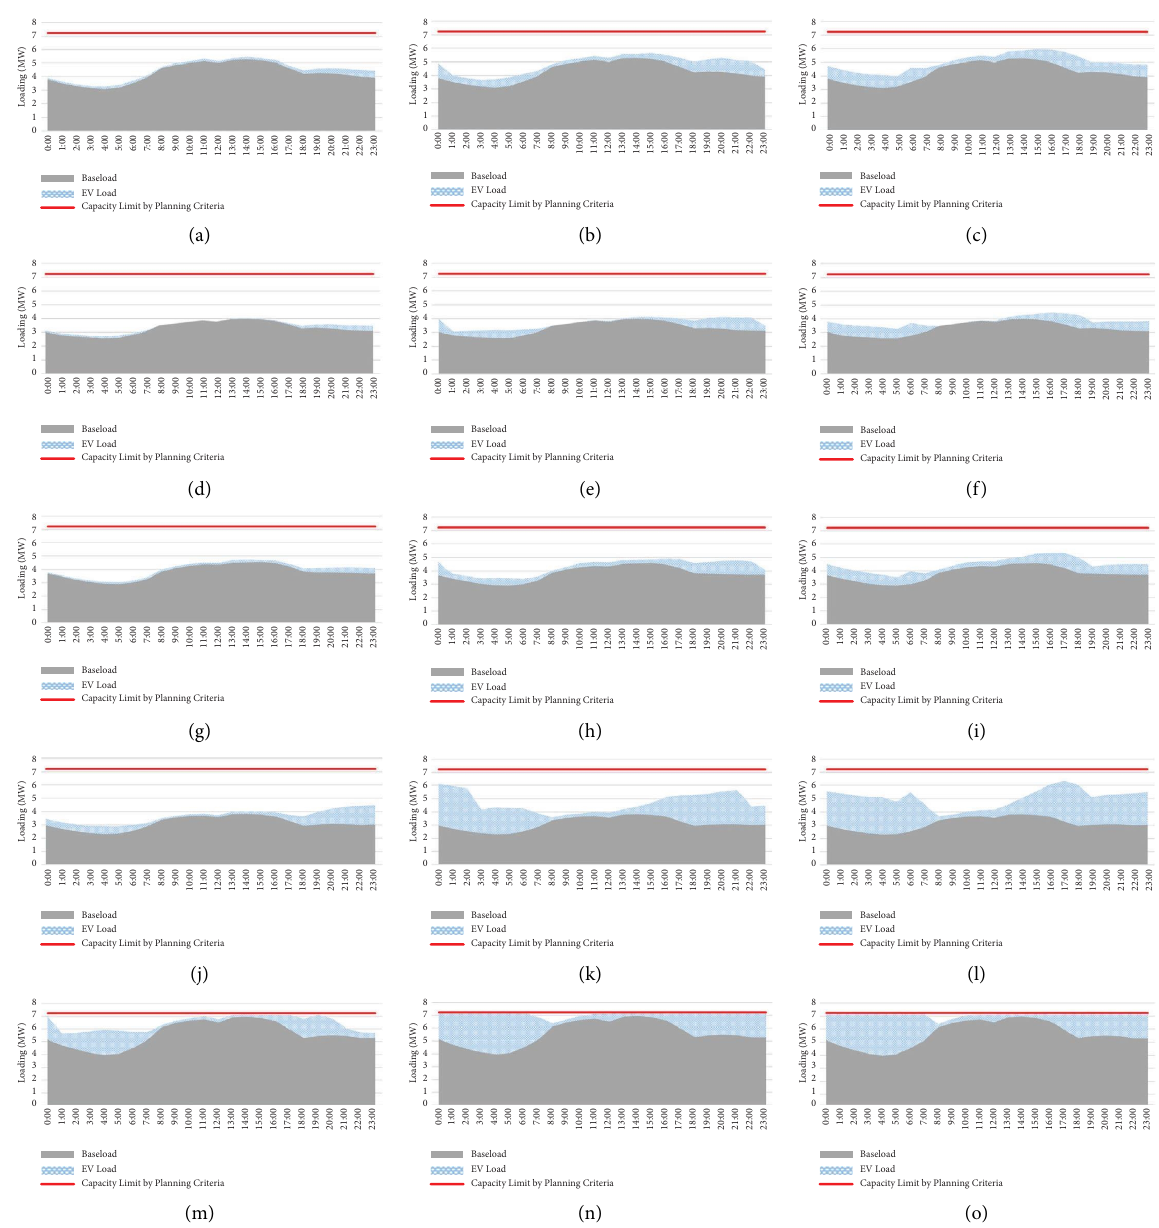
Figure 15: Capacity loading of fve primary feeders under the three scenarios of EV penetration for smart charging. Primary feeder no. 1 with (a) 10%, (b) 30%, and (c) 50% EV penetration. Primary feeder no. 2 with (d) 10%, (e) 30%, and (f) 50% EV penetration. Primary feeder no. 3 with (g) 10%, (h) 30%, and (i) 50% EV penetration. Primary feeder no. 4 with (j) 10%, (k) 30%, and (l) 50% EV penetration. Primary feeder no. 5 with (m) 10%, (n) 30%, and (o) 50% EV